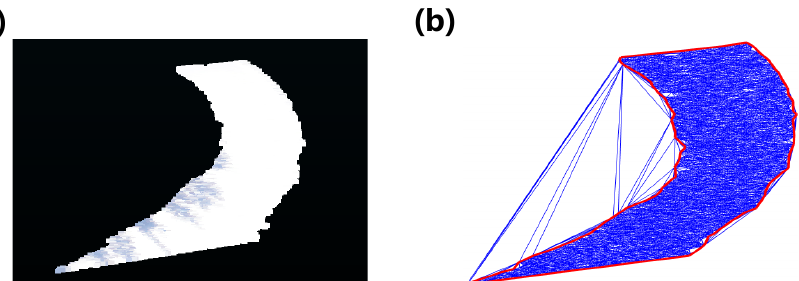
Figure 13. The second group of data-processing results for the Beijing Winter Olympics National Cross-country Skiing Center (Parameters: T = 2.0 cm, A = 0.7, D = 40 cm): ( a ) color point cloud; ( b ) ski-track